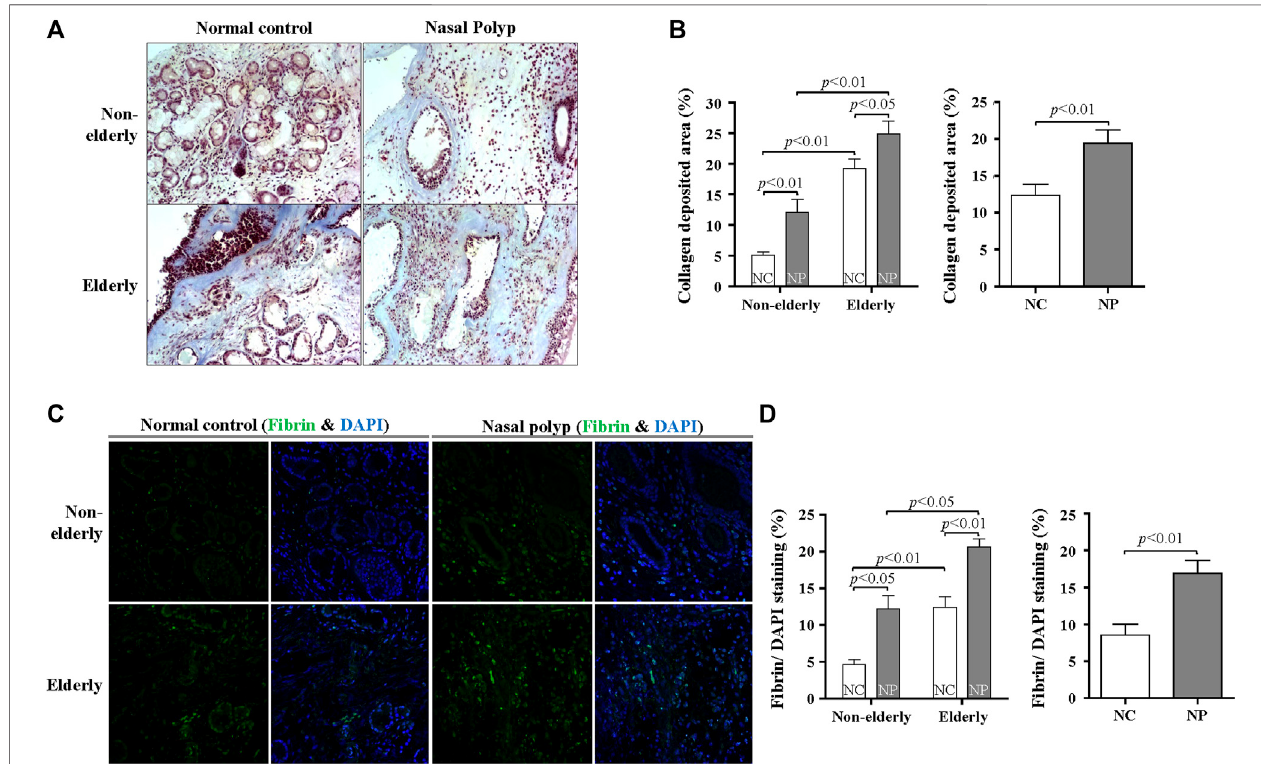
FIGURE 5 | Age-related difference in collagen and fi brin deposition in subjects with NP and normal controls. (A) Masson ’ s trichrome staining was conducted to evaluate collagen deposition (blue color). Original magni fi cation, ×200. (B) Quanti fi cation of trichrome-stained area (%) per high power fi eld of each group. Data are expressedasthemeans±SE(non-elderlyNCversuselderlyNC, n =10, p < 0.01;non-elderlyNPversuselderlyNP, n =10, p < 0.01;NCversusNP, n =20, p < 0.01) (C) Representativeimmuno fl uorescenceimagesstainedwith fi brin(green)andDAPI(blue).Originalmagni fi cation:×400. (D) Quanti fi cationofthe fl uorescencearea(%) of fi brinperDAPI-stainednuclei.Dataareexpressedasthemeans±SE(non-elderlyNCversuselderlyNC, n =10, p < 0.01;non-elderlyNPversuselderlyNP, n =10, p < 0.05; NC versus NP, n = 20, p < 0.01). NC, normal control; NP, nasal polyp.